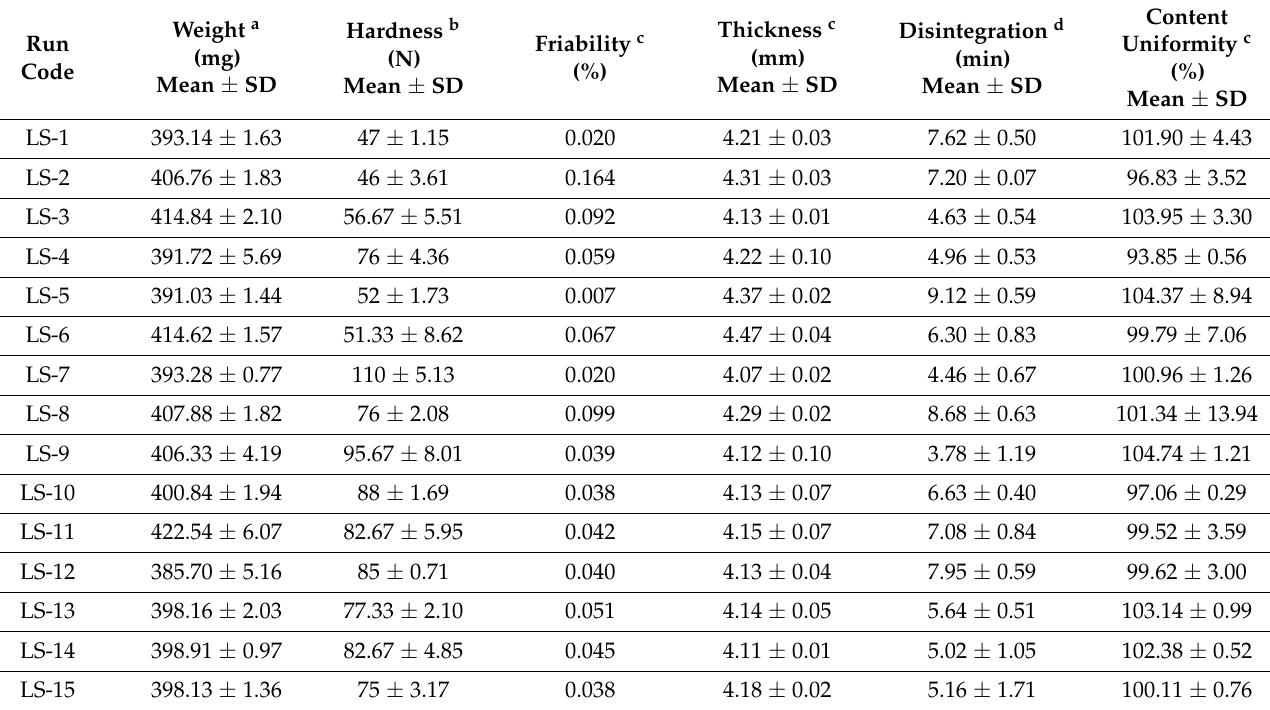
Table 4. Results of the quality control tests for the prepared glimepiride liquisolid